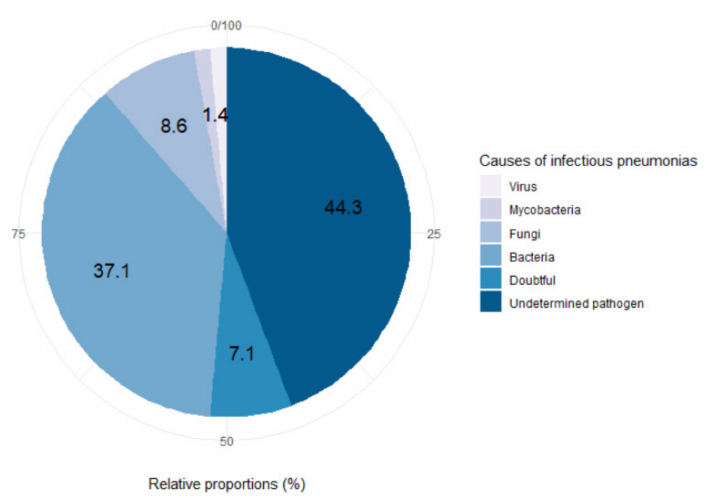
Figure 3. Pie chart of the causes of infectious pneumonias occurring in myelodysplastic patients.